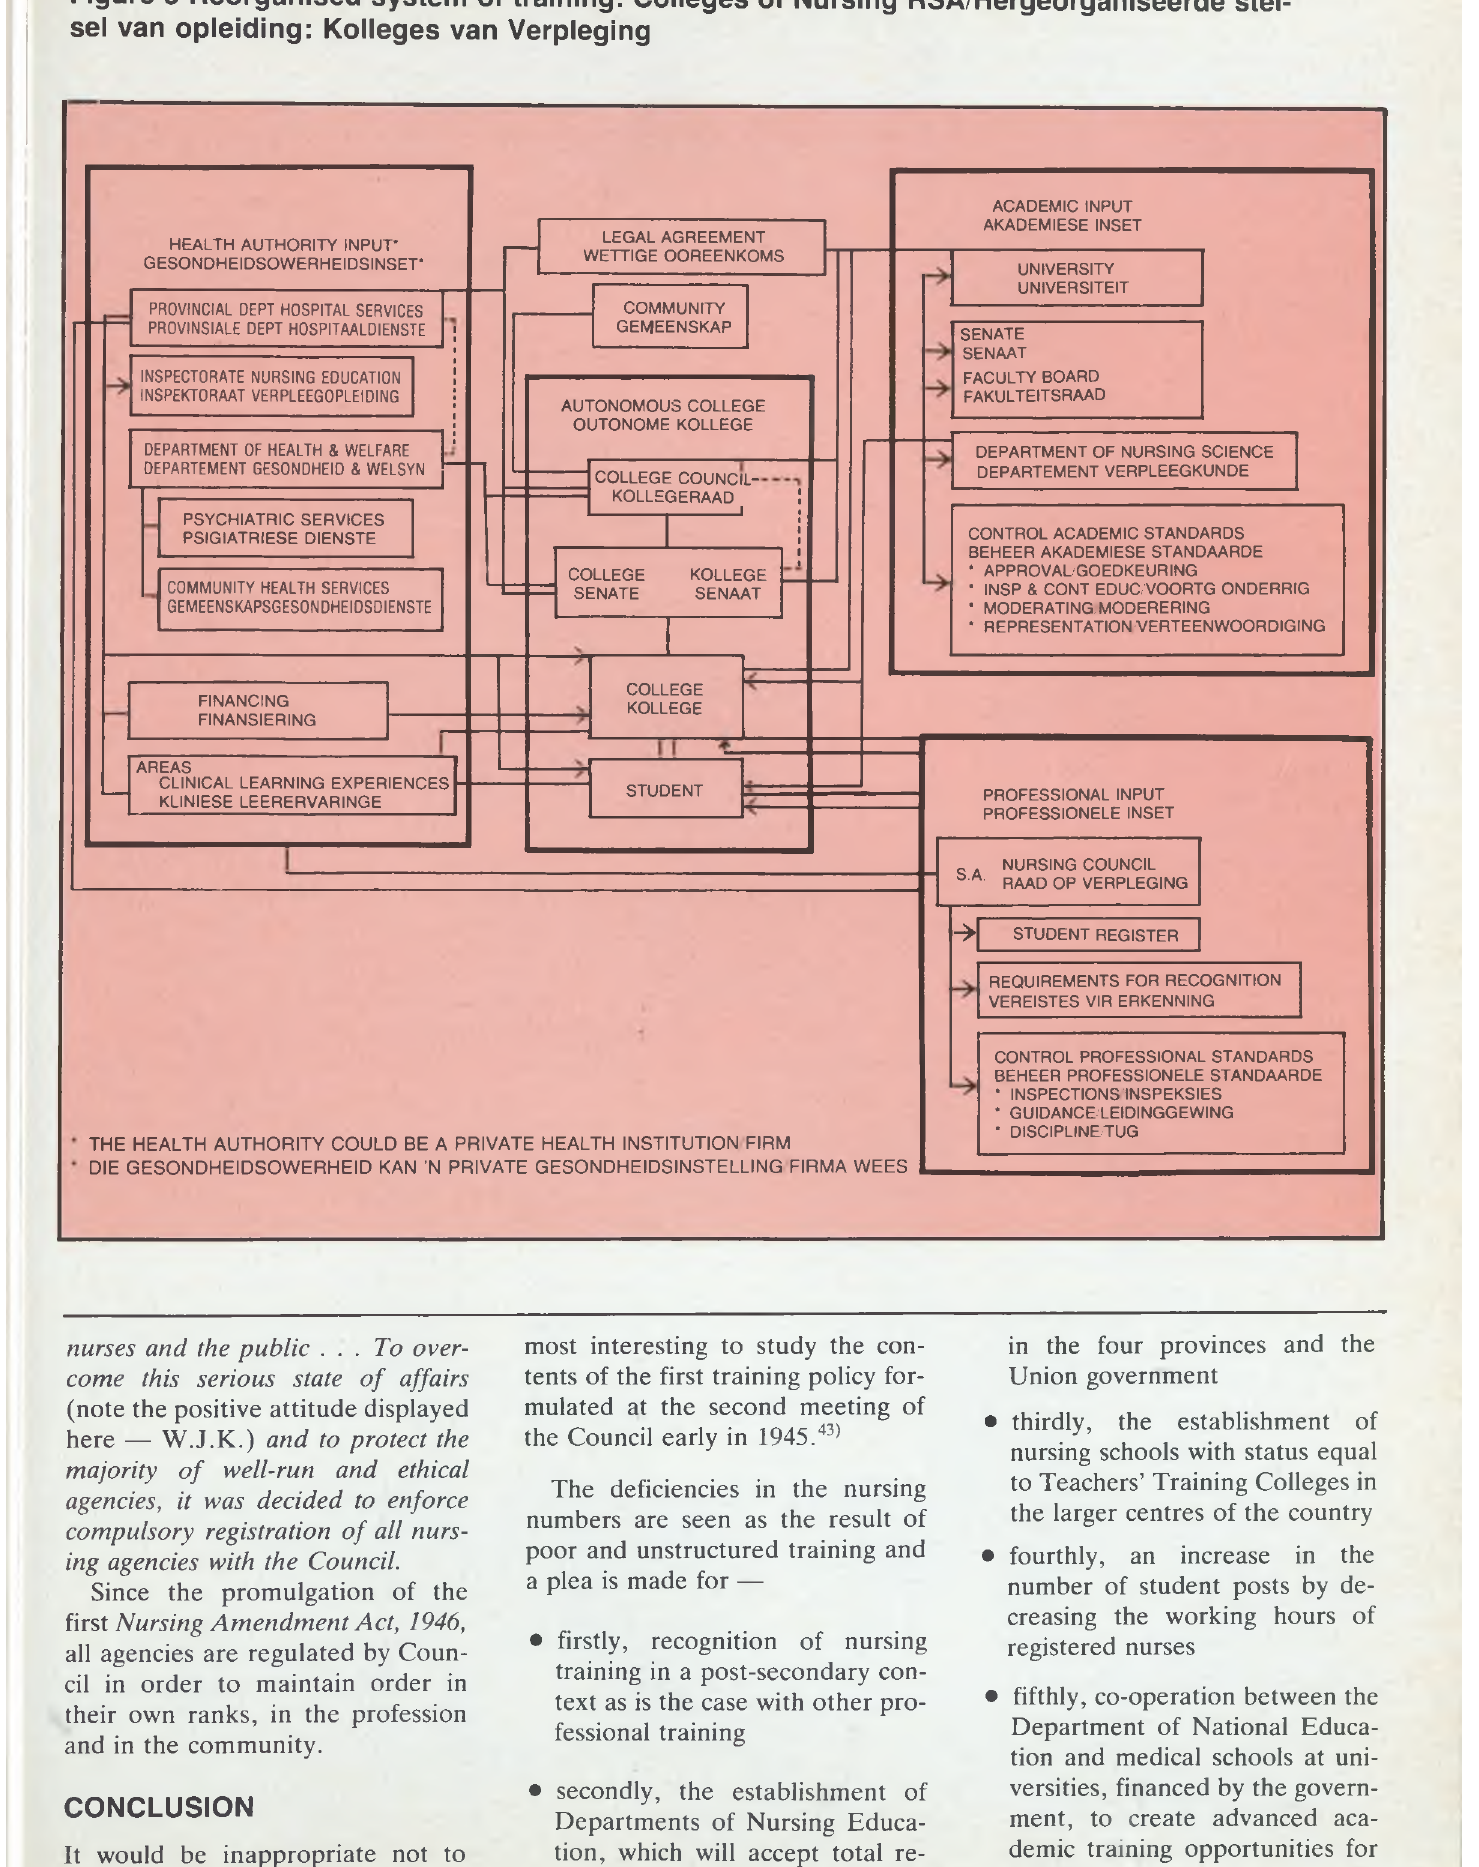
Figure 3 Reorganised system of training: Colleges of Nursing RSA/Hergeorganiseerde